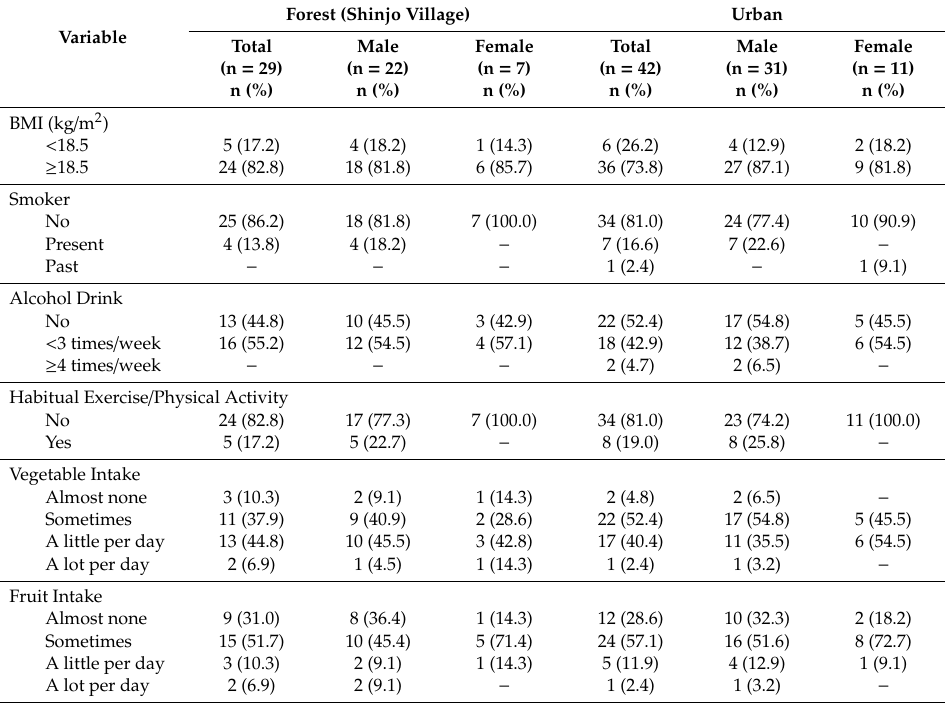
Table 1. Anthropometric and Demographic Data.